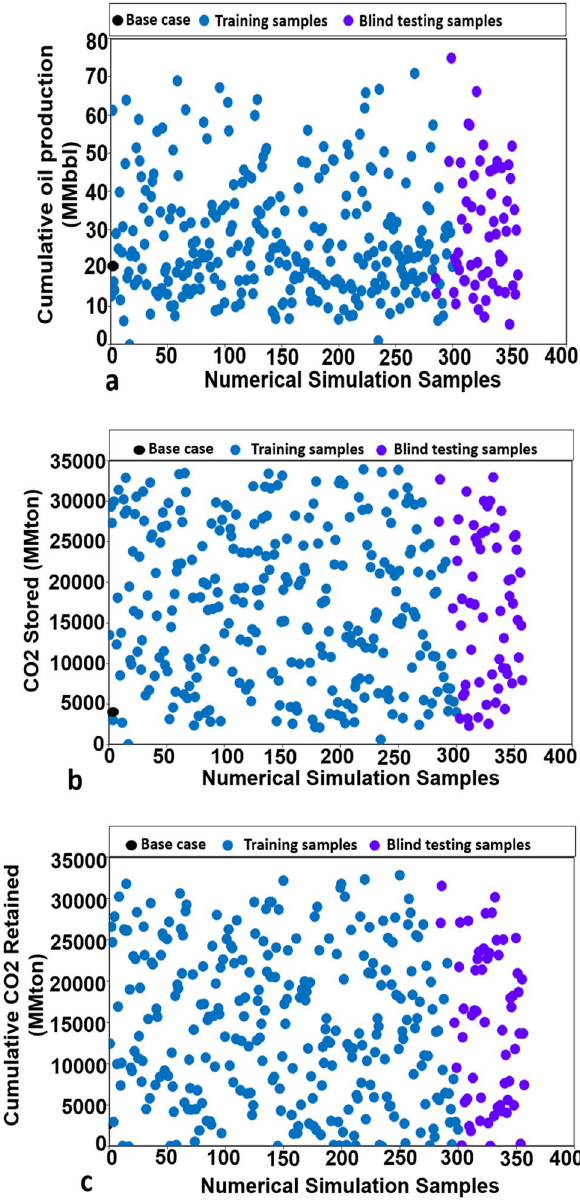
Figure 3. The numerical simulation samples for training and blind testing ANN models. ( a ) The samples of cumulative oil production. ( b ) The samples of cumulative CO 2 stored. ( c ) The samples of cumulative CO 2